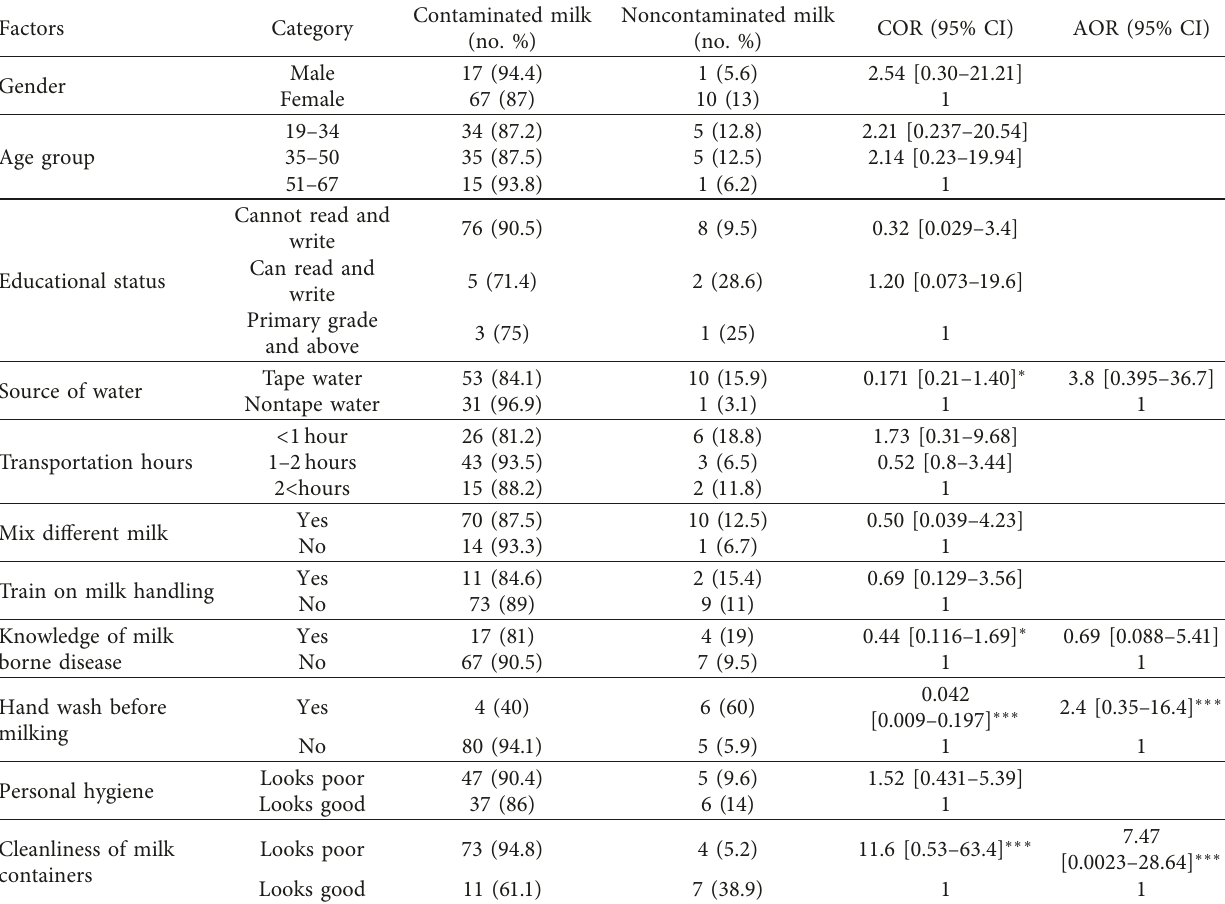
Table 6: Factors associated with contamination of raw milk from producers in Gomole district, Borena zone, South Ethiopia, 2019. Factors